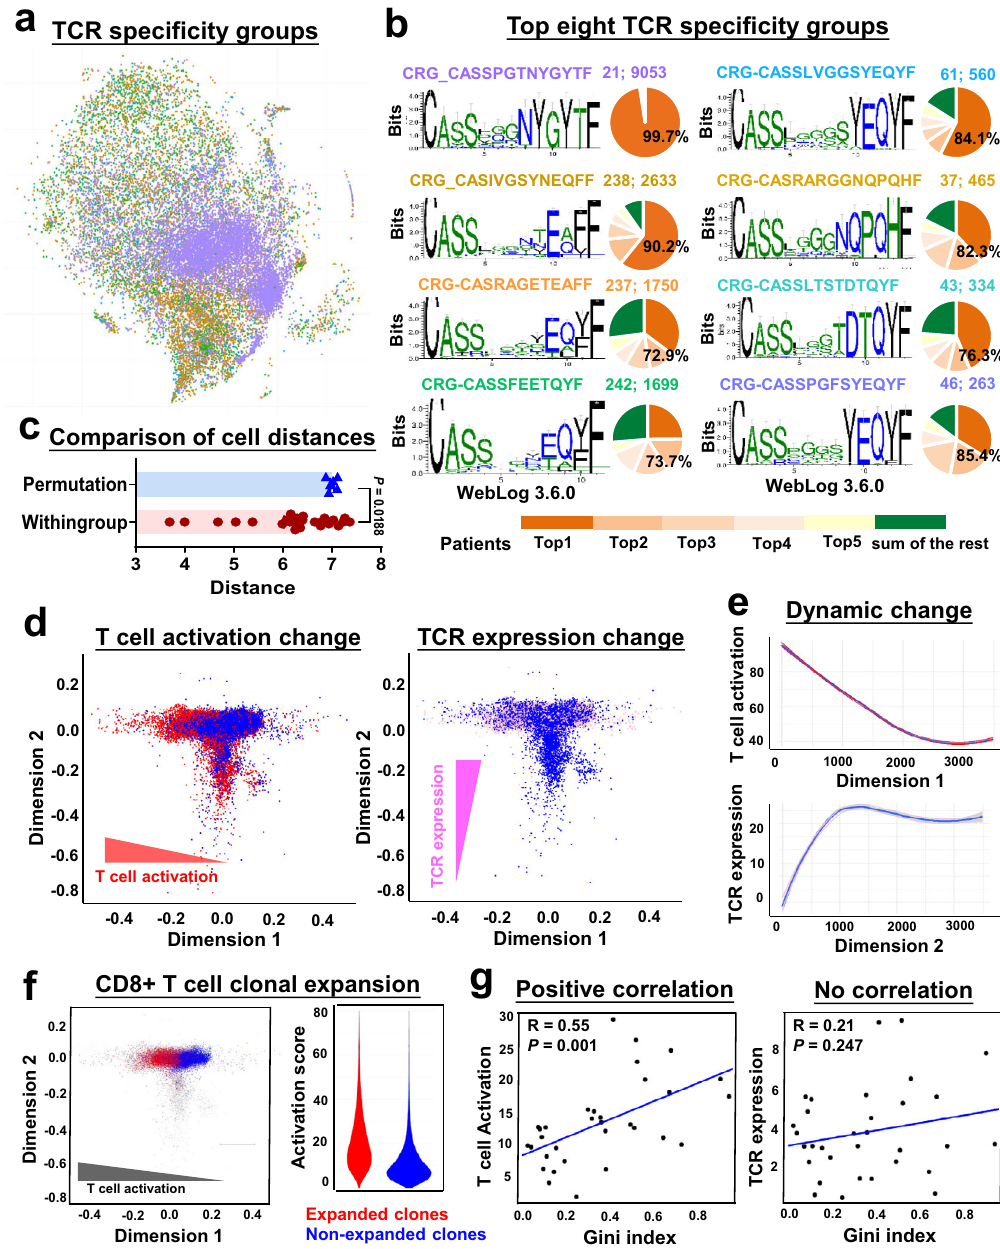
Fig. 4 TCR usage and activation stages shape T cell phenotypes. a The same t-SNE plot in Fig. 1b with single T cells from all patients and healthy donors, colored by TCR speci fi city groups identi fi ed by GLIPH. b Sequences and corresponding weblogs of top eight TCR speci fi city groups with more than fi ve different CDRs. In each panel, pie chart on the right indicates percentages for this TCR speci fi city group in top 5 patients (number in a black color) and in all other patients. In numbers A; B following CRG sequences, A indicates the number of clones contained in the CRG, B indicates the frequency of this CRG in all cells. c Distances of cells within the same TCR speci fi city group were compared to permutated distances of any random cells in the t-SNE plot; two-sided unpaired Mann – Whitney test. P value = 0.0188. d Diffusion maps to visualize components of CD8 + T cell phenotype variation from all patients and healthy donors. Each dot represents a CD8 + T cell. T cell activation, TCR expression, and all other cells are colored in red, pink, and blue, respectively, with dimension 1 on x -axis and dimension 2 on y -axis. Diffusion maps showing dynamic changes of T cell activation on dimension 1 (left, in red) and TCR expression on dimension 2 (right, in pink). e Curves indicate dynamic changes of T cell activation and TCR expression along on dimension 1 and dimension 2 revealed on diffusion maps, respectively. x -axis, dimensions on diffusion maps; y -axis, imputed expression of T cell activation (top, in red) and TCR expression (bottom, in pink) components. Solid lines in red and pink represent 5 – 95% interval, illustrated by shaded areas; blue line shows a medium. f Diffusion map of CD8 + T cells on dimension 1 and dimension 2, and colored by clonal expansion (red for expanded clones). Higher activation is observed in expanded clones than in non-expanded clones (a violin plot on the right). g Gini index positively correlated with T cell activation (left) but not with TCR expression (right). Each dot indicates one sample. A Pearson correlation test.